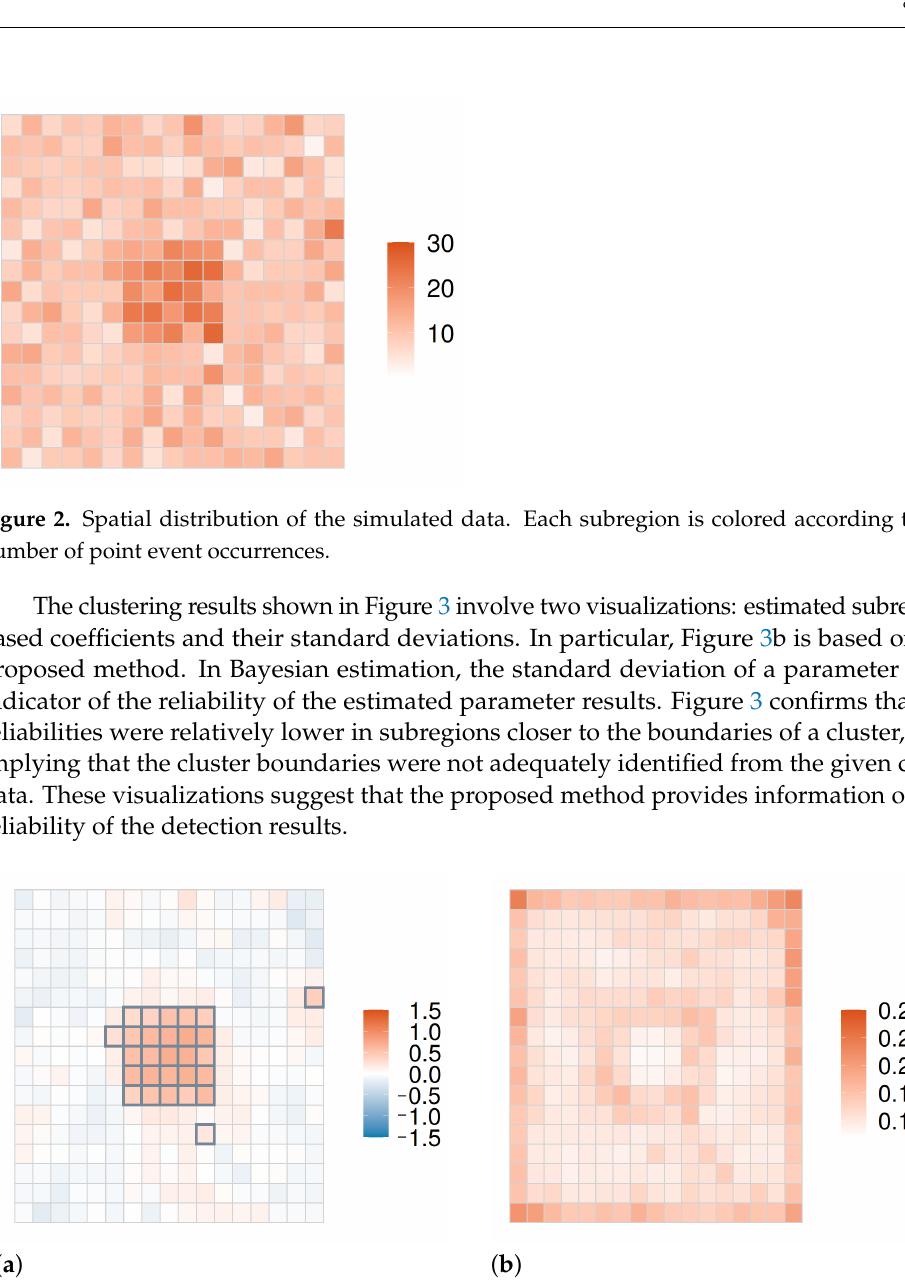
Figure 3. Results of the proposed method for Figure 2. ( a ) Estimated subregion-based coefficients. The color of each subregion corresponds to the degree of concentration, and subregions enclosed within bold lines are detected as constituting a cluster. ( b ) Standard deviation of the estimated subregion- based coefficients. The darker colors represent lower reliabilities for the estimated coefficients in the corresponding